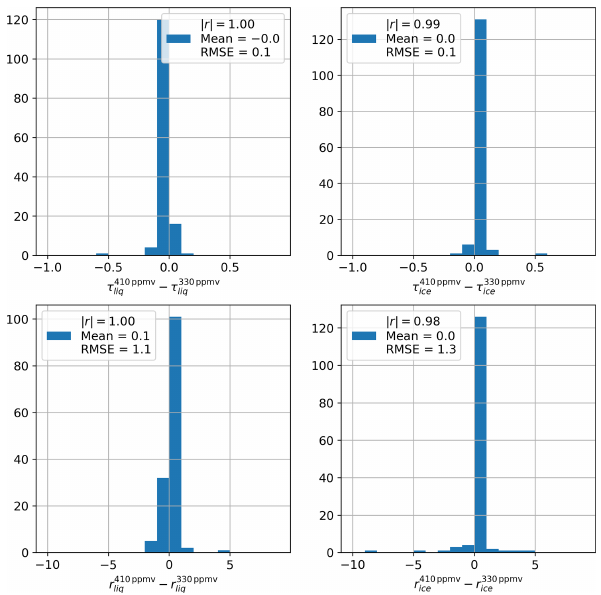
Figure D1. Histograms of differences for CO 2 concentrations of 410 and 330ppm for τ liq , τ ice , r liq and r ice .